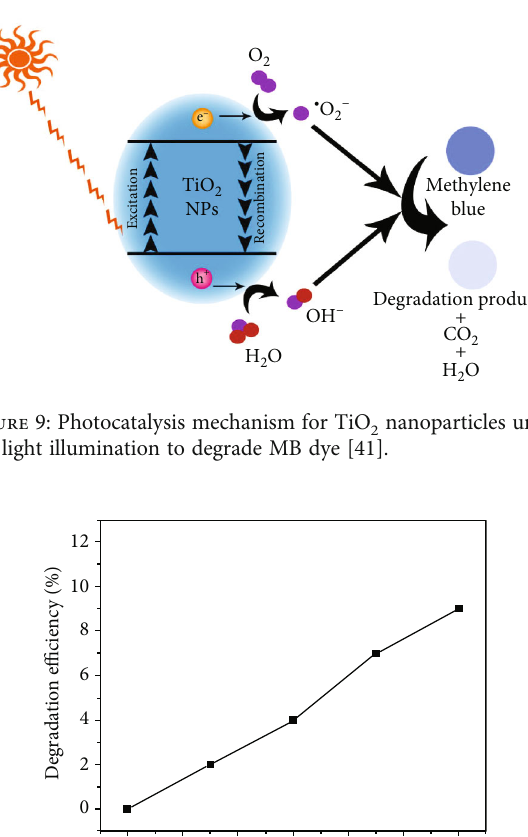
nanoparticles in the 2